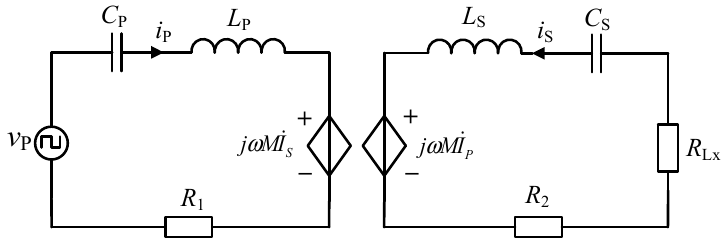
Figure 2. The equivalent circuit for SS wireless transmission.